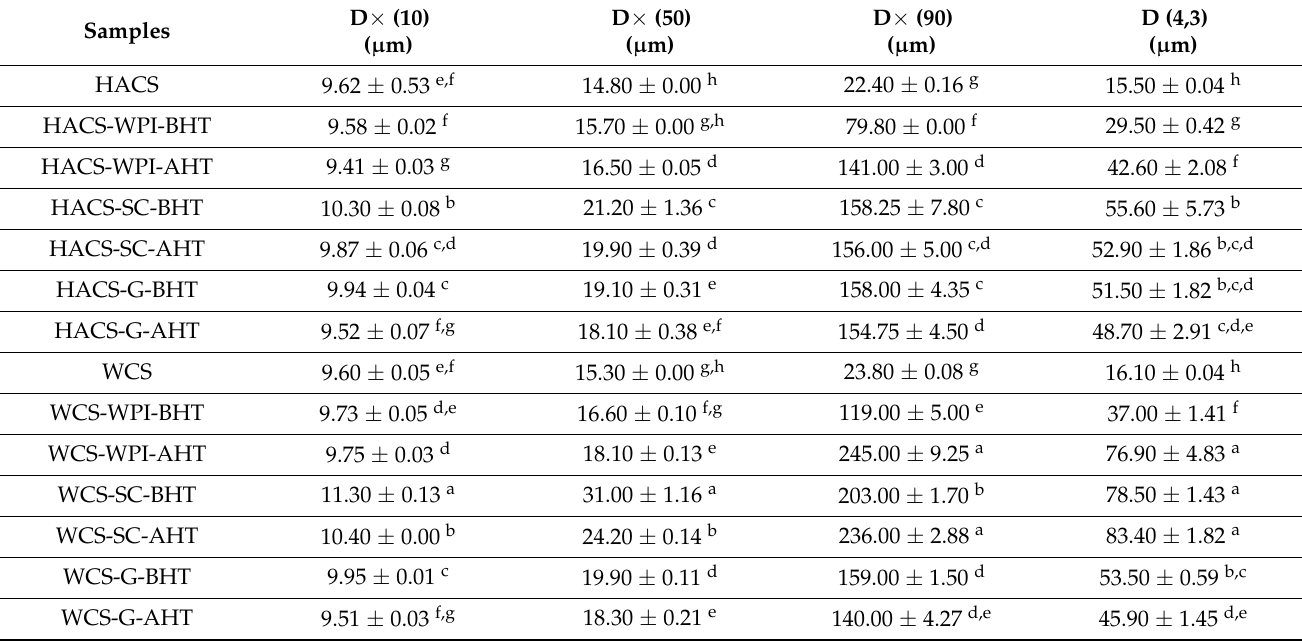
Table 3. Particle size distribution of native and protein-coated waxy corn starch (WCS) and high amylose corn starch (HACS) prepared by the wet mixing method before and after